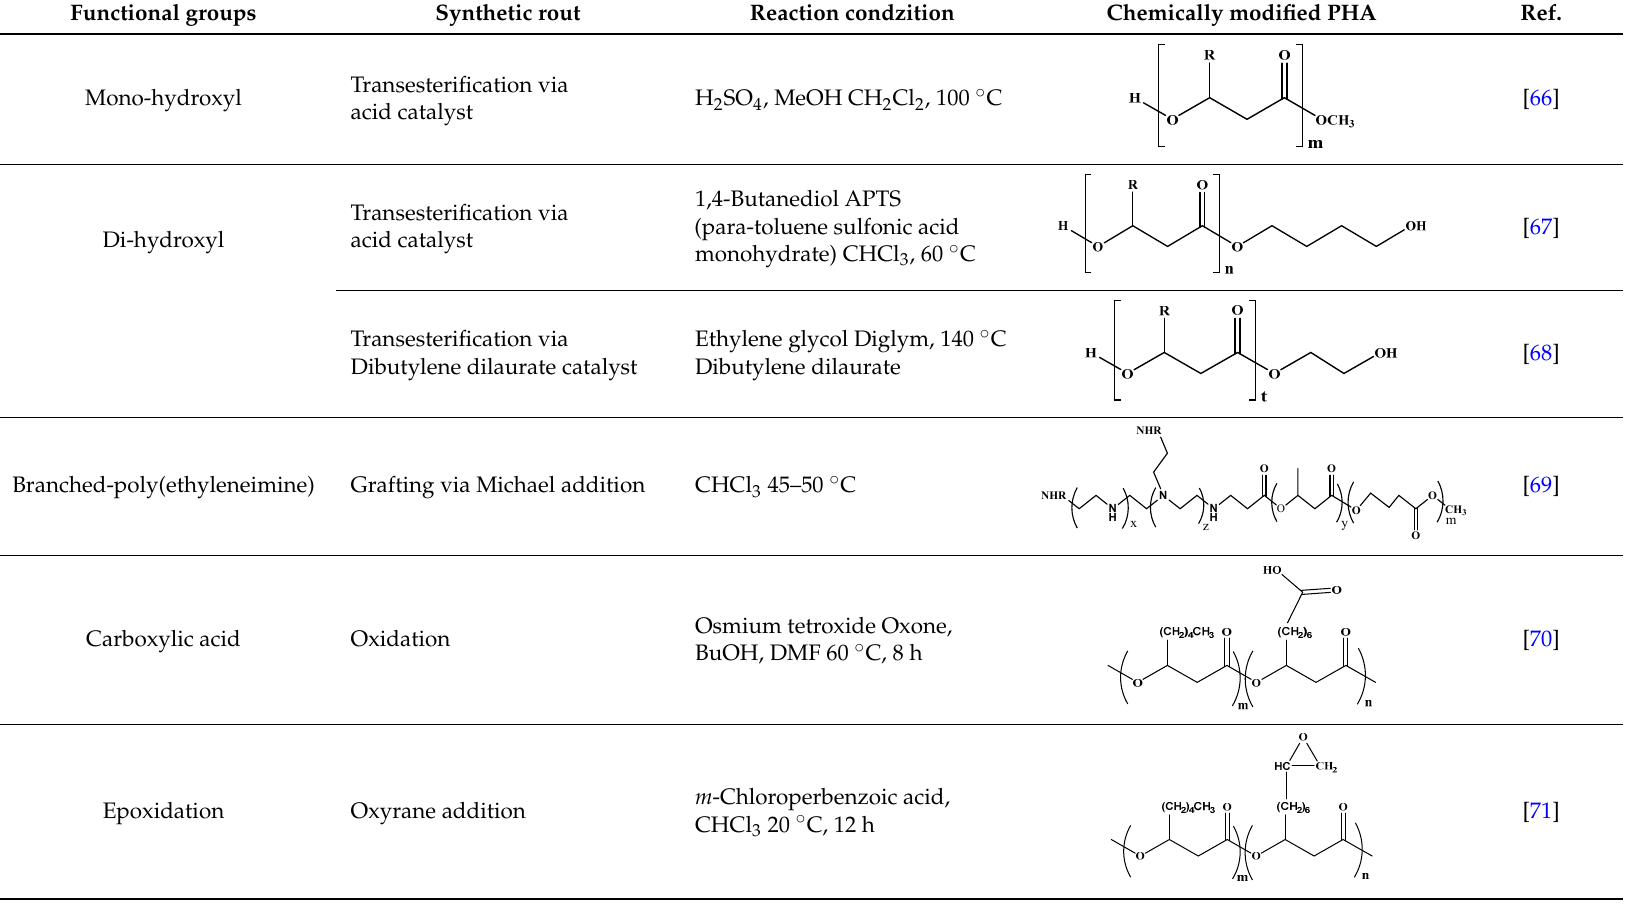
Table 2. Chemical modification of polyhydroxyalkanoate surface via different synthetic routes.